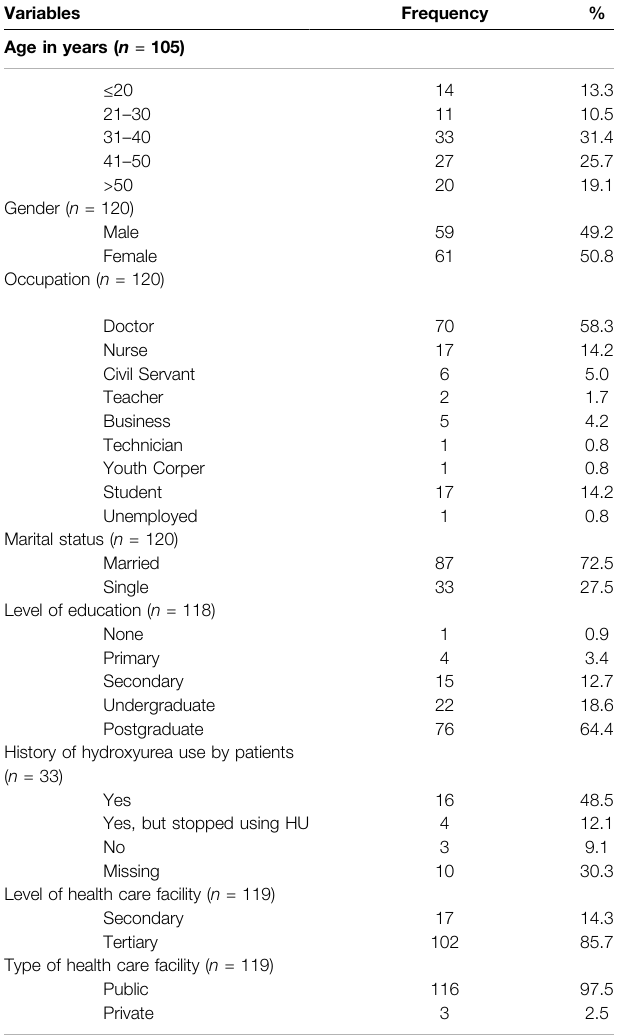
TABLE 1 | Characteristics of study population and various clinical study facilities across Nigeria, 2019 ( N (cid:1) 120).